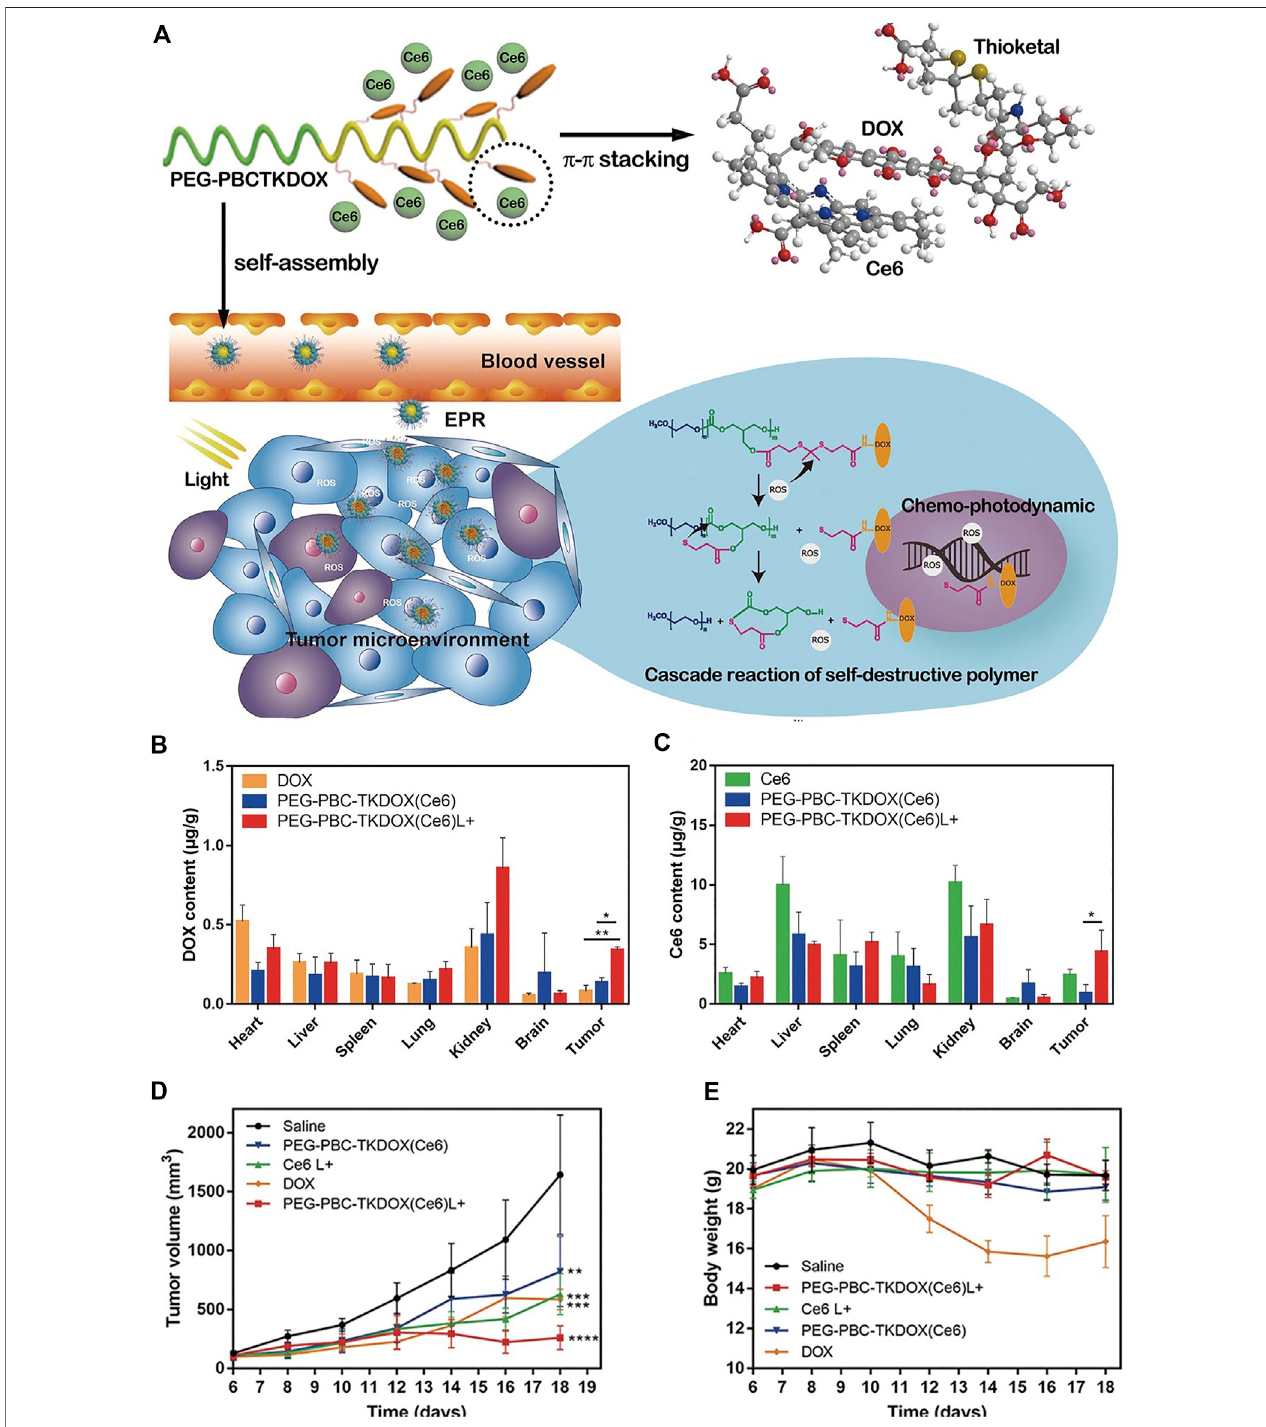
FIGURE 7 | (A) Schematic drawing of the cascade reaction of self-destructive polymeric nanomicelles; (B) biodistribution of DOX solution and PEG-PBC-TKDOX (Ce6) micelles at 12 h with or without light irradiation; (C) biodistribution of Ce6 solution and PEG-PBC-TKDOX (Ce6) micelles at 12 h with or without lightirradiation; (D) growth curves of subcutaneously inoculated KB tumors. Intravenous injections were given to mice at day 7, day 9, and day 11. The 660 nm laser irradiation followed at 12 h after each injection; (E) body weight changes ( n (cid:1) 5, **, p < 0.01, ***, p < 0.001, ****, p < 0.0001). Reprinted with permission from Wang et al. (2019).